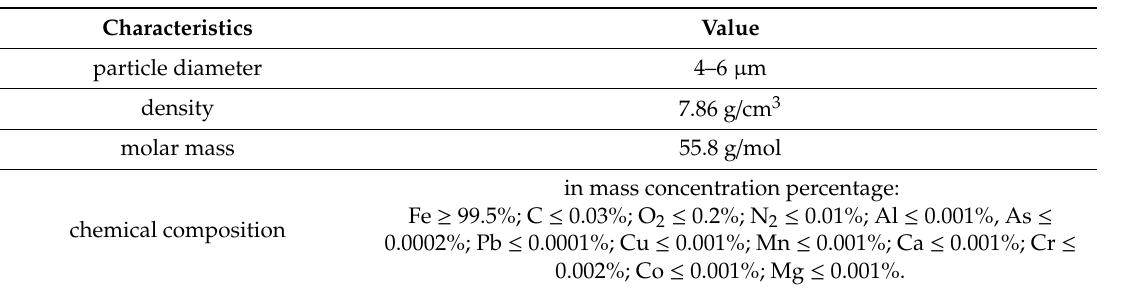
Table 3. Fe particle